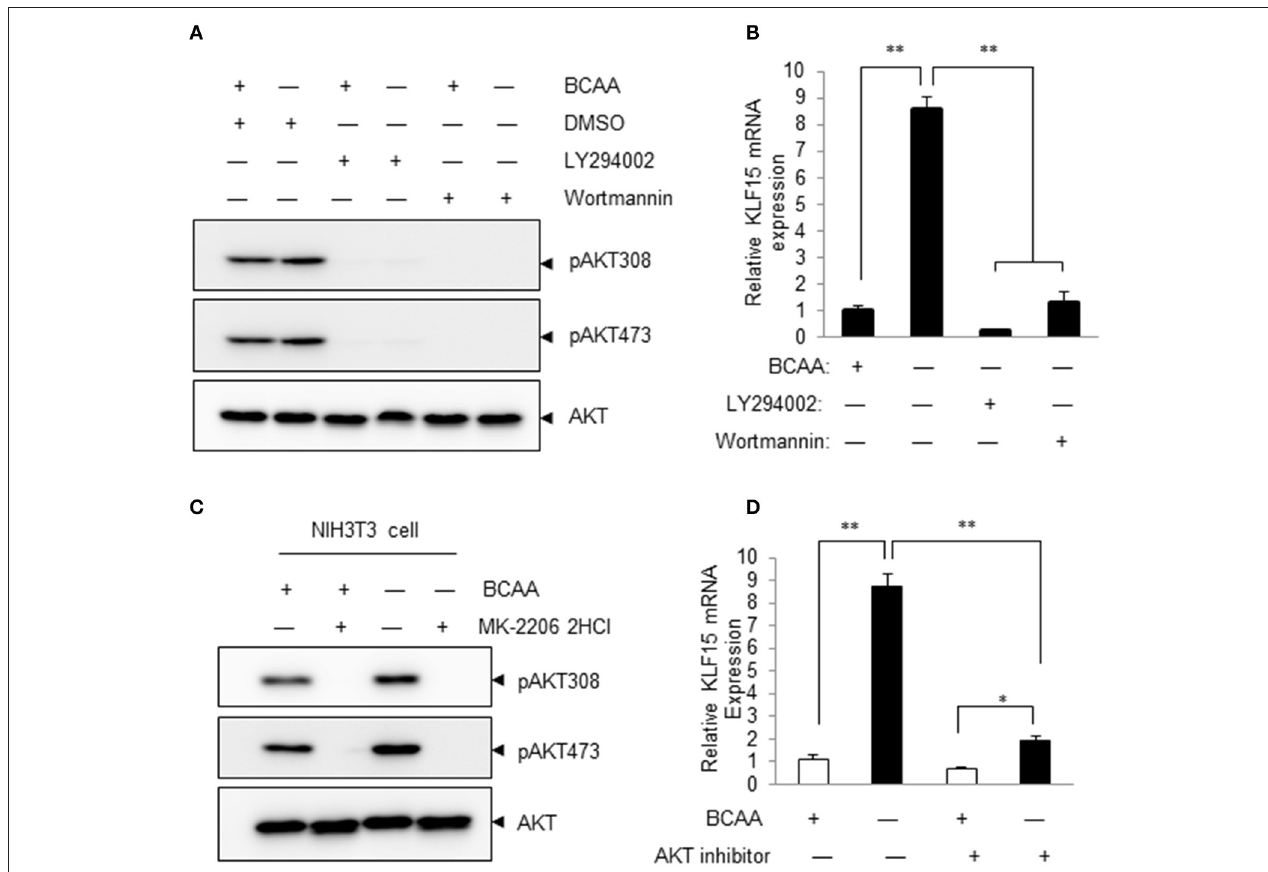
FIGURE 4 | Inhibitors of PI3K and AKT attenuate BCAA-starvation-induced KLF15 expression. (A) Measurements of Ser473 or Thr308 phosphorylation of AKT (pAKT) or total AKT (60KD band) using immunoblots. Cells were pretreated 60min with 10 µ M LY294002 or 1 µ M Wortmannin before BCAA deprivation ( − ) for 2h. Data showed 1 experiment representative of 3. (B) Cells were pretreated 60min with 10 µ M LY294002 or 1 µ M Wortmannin before BCAA deprivation ( − ) for 4h and then harvested for measurement of KLF15 mRNA by quantitative PCR. (C) Measurements of Ser473 or Thr308 phosphorylation of AKT (pAKT) or total AKT (60KD band) using immunoblots. Cells were pretreated 60min with 10 µ M AKT inhibitor MK-2206 before BCAA deprivation ( − ) for 2h. Data showed 1 experiment representative of 3. (D) Cells were pretreated 60min with 10 µ M AKT inhibitor MK-220 before BCAA deprivation ( − ) for 4h and then harvested for measurement of KLF15 mRNA by quantitative PCR. Data are means ± SE for three individual samples. * p < 0.05, ** p < 0.01.